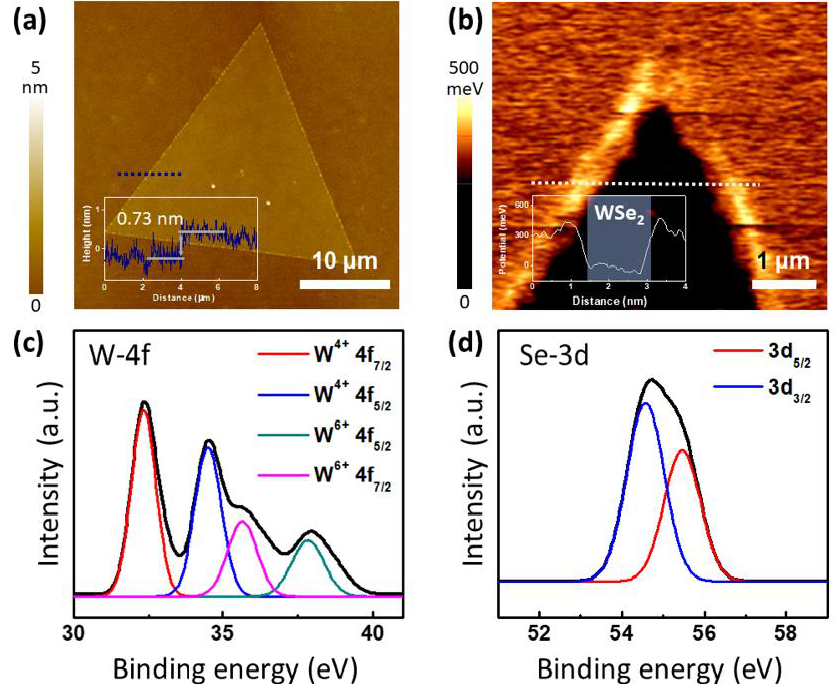
Figure 4. ( a ) Atomice force microscopy (AFM) image of the synthesized monolayer WSe 2 . The inset graph is the height profile corresponding to the blue dot line. ( b ) Surface potential mapping image of WSe 2 by Kelvin probe force microscopy (KPFM). The inset graph is the surface potential profile corresponding to the white dot line. X-ray photoelectron spectroscopy (XPS) analysis of ( c ) W-4f and ( d ) Se-3d of synthesized WSe 2 .